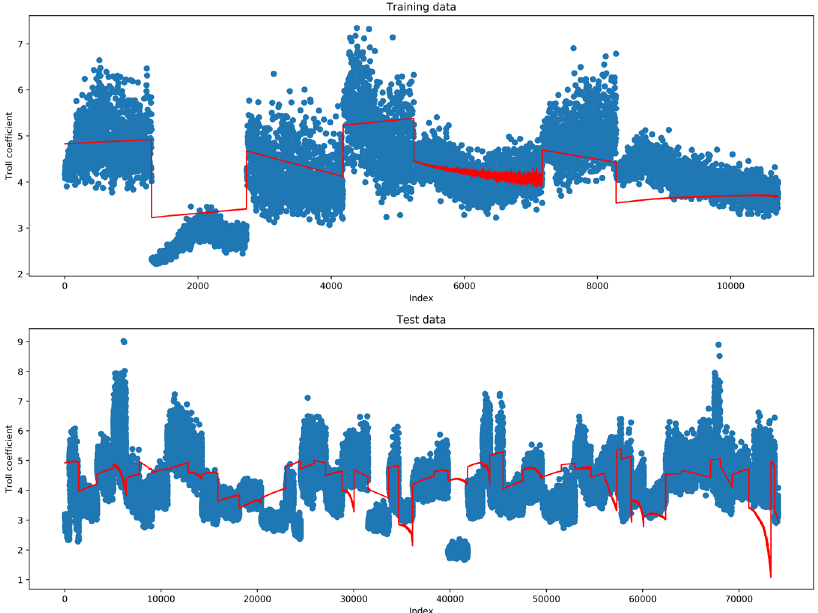
Fig. 5 Apps ’ troll coef fi cients. In-sample and out-of-sample